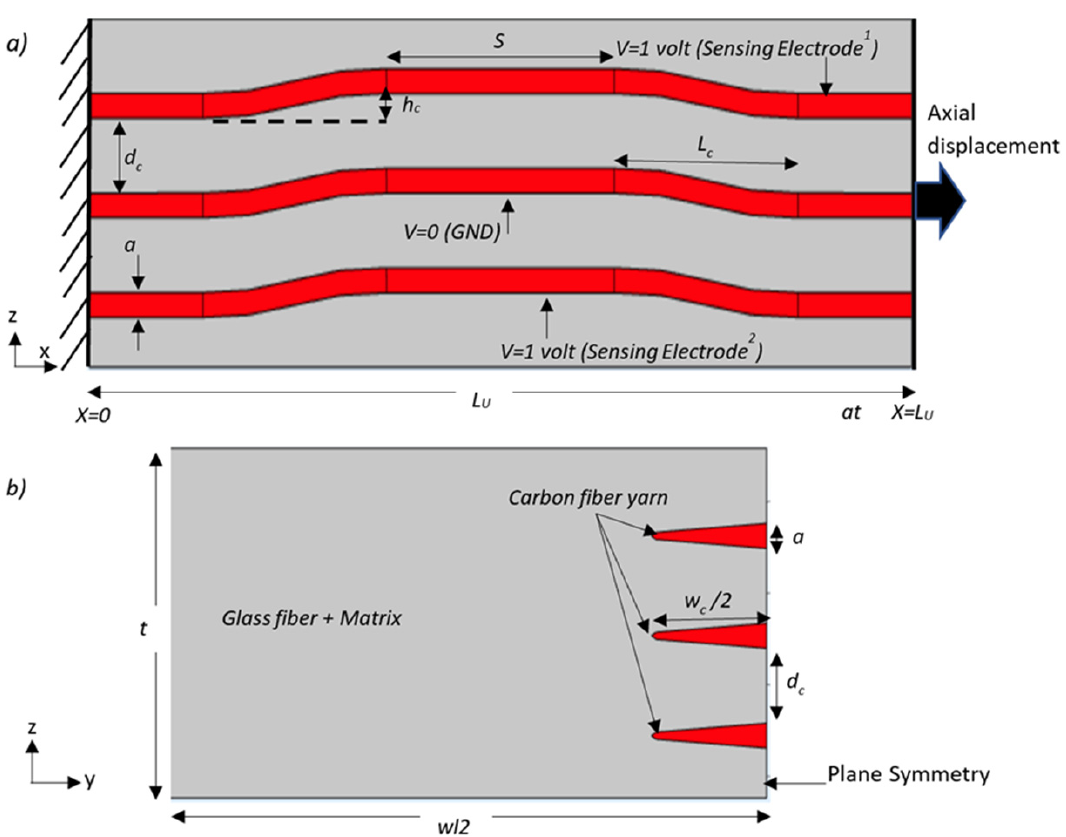
Figure 10. The unit cell’s main geometric parameters for integrating carbon yarn into the epoxy impregnated 2/2 twill weave glass fabric. Schematic cross-sectional diagram of ( a ) the front view and ( b ) side view of the unit cell. Table 5. The main parameters of the unit cell considered.